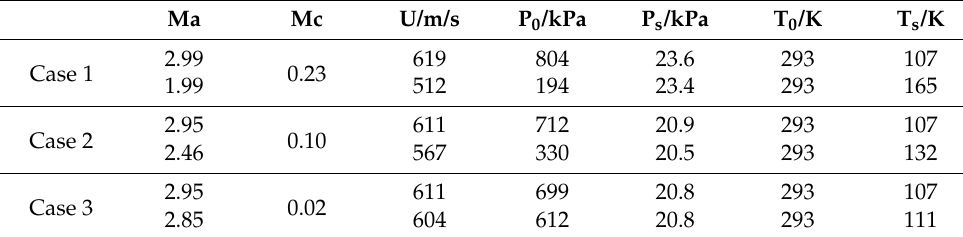
Table 2. Operation conditions of the wind tunnel.